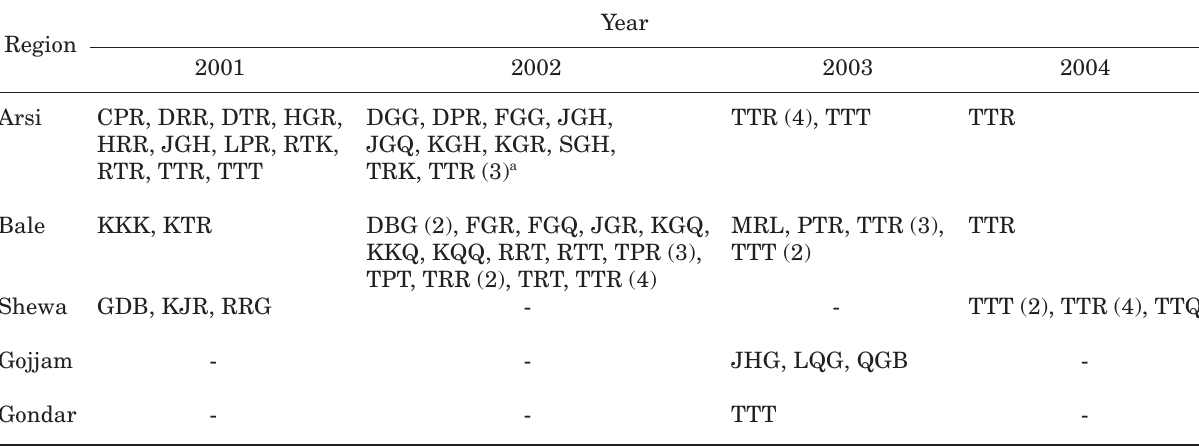
Table 5. Races of Puccinia graminis f. sp. tritici found in the Arsi, Bale, Shewa, Gojjam and Gondar regions of Ethiopia in 2001, 2002, 2003 and 2004.